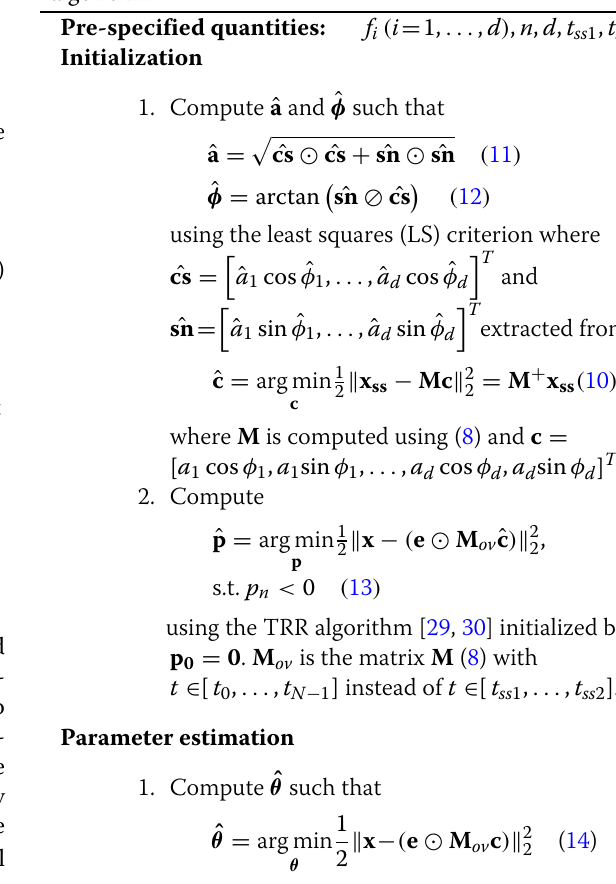
Algorithm 1: Transient Current Estimation (TCE)